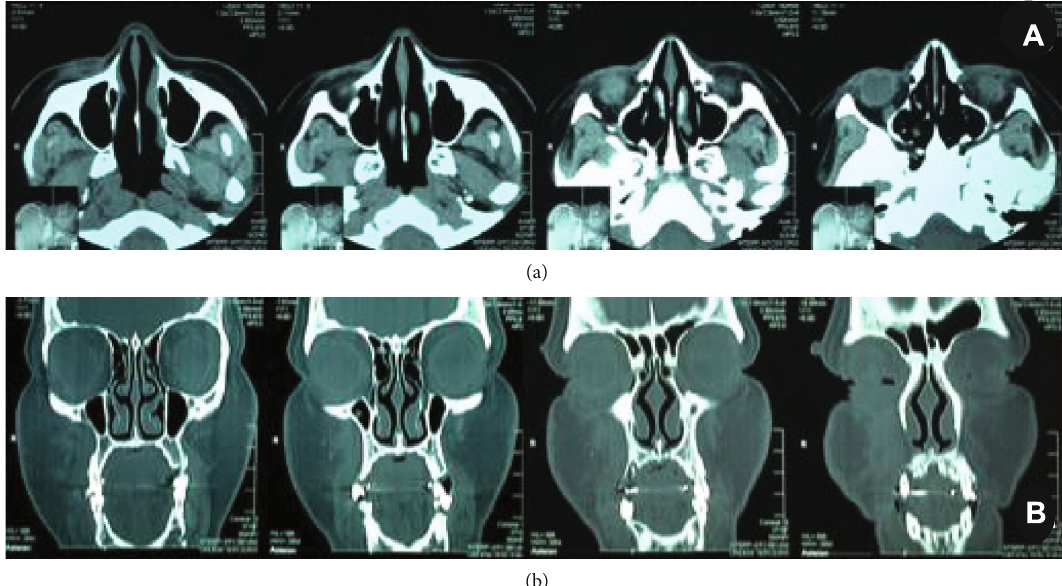
Figure 5: (a) Axial plane and (b) coronal plane, showing the postoperative aspects of the a ff ected